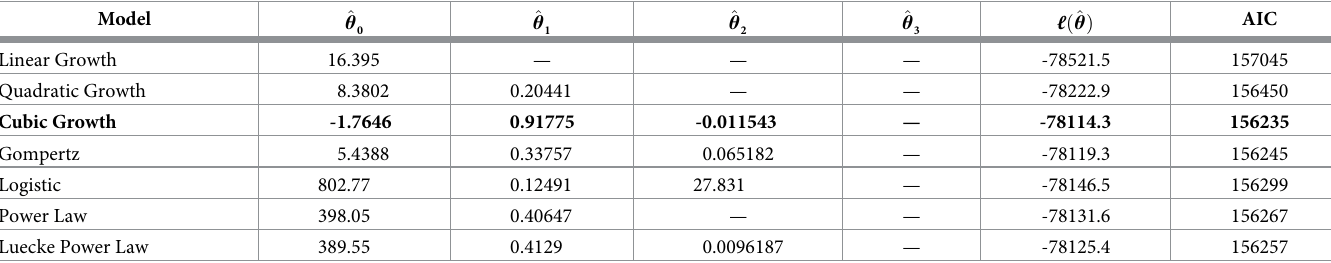
Table 11. Placenta volume models (volume in mL vs. fetal mass in kg for power law models, volume in mL vs. gestational age in weeks for all other models).